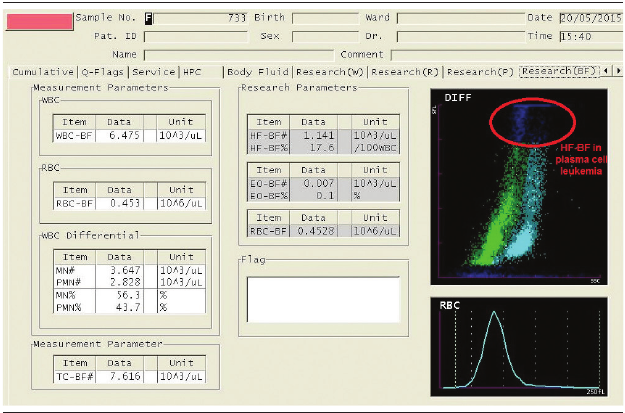
figurE 2 − Scattergram displayed on XE-5000 from a pleural effusion with plasma cells in plasma cell leukemia Ascitic